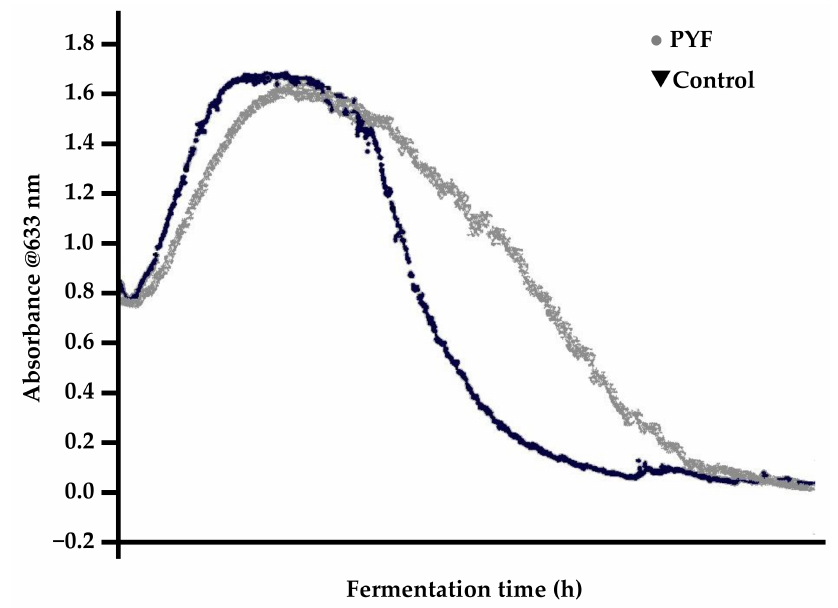
Figure 14. Test tube-sized (15 mL) fermentations of a premature yeast flocculation (PYF) and control malt yeast in suspension continuously measured